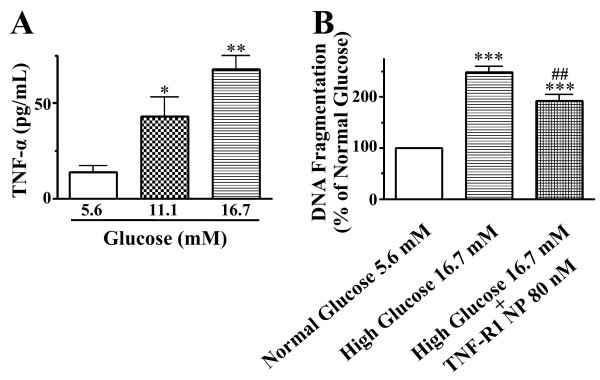
TNF-α production and TNF-R1 neutralizing peptides-sensitive apoptosis in HCAECs under high glucose conditions. A: Effect of high glucose on TNF-α levels in cell culture supernatants, analyzed by ELISA. Values are expressed as mean ± SE (n = 3). **P < 0.05, ***P < 0.01 versus normal glucose (5.6 mM). B: Effect of TNF-R1 neutralizing peptides on high glucose-induced endothelial cell apoptosis. TNF-R1 neutralizing peptides (80 nM) were given in HCAECs treated with 16.7 mM glucose for 24 h. The DNA fragmentation was assayed as a biochemical hallmark of apoptosis. Values are expressed as mean ± SE (n = 3). ***P < 0.001 versus control (normal glucose); ##P < 0.01 versus high glucose treatment alone.